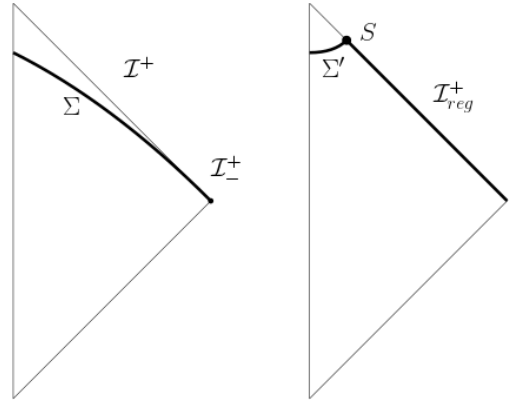
Figure 2 . Di(cid:11)erent ways of turning I + into a Cauchy surface. Either a) consider a constant time t = T ! 1 as in the left panel, or b) cutting the null in(cid:12)nity at large u and attaching to it a spacelike surface which extends to r = 0 as in the right